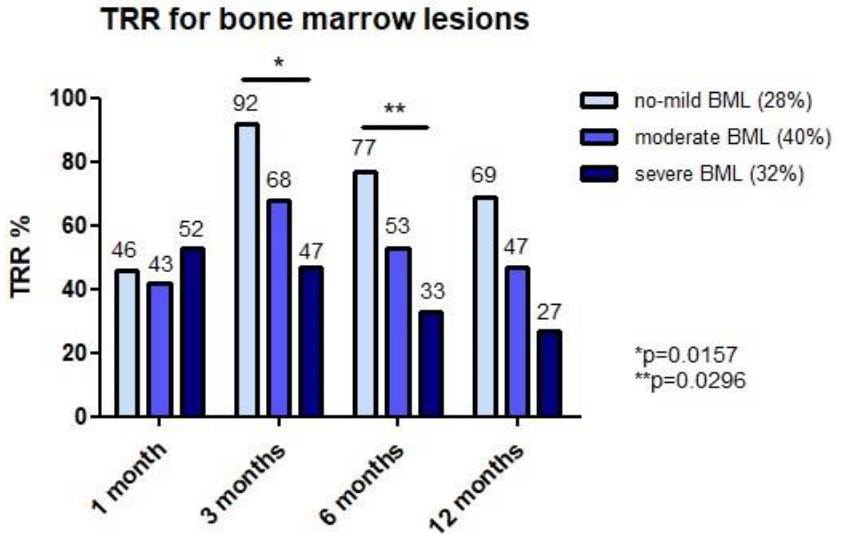
Figure 6. Therapeutic response rate (TRR%) for bone marrow lesion (BML) classification.